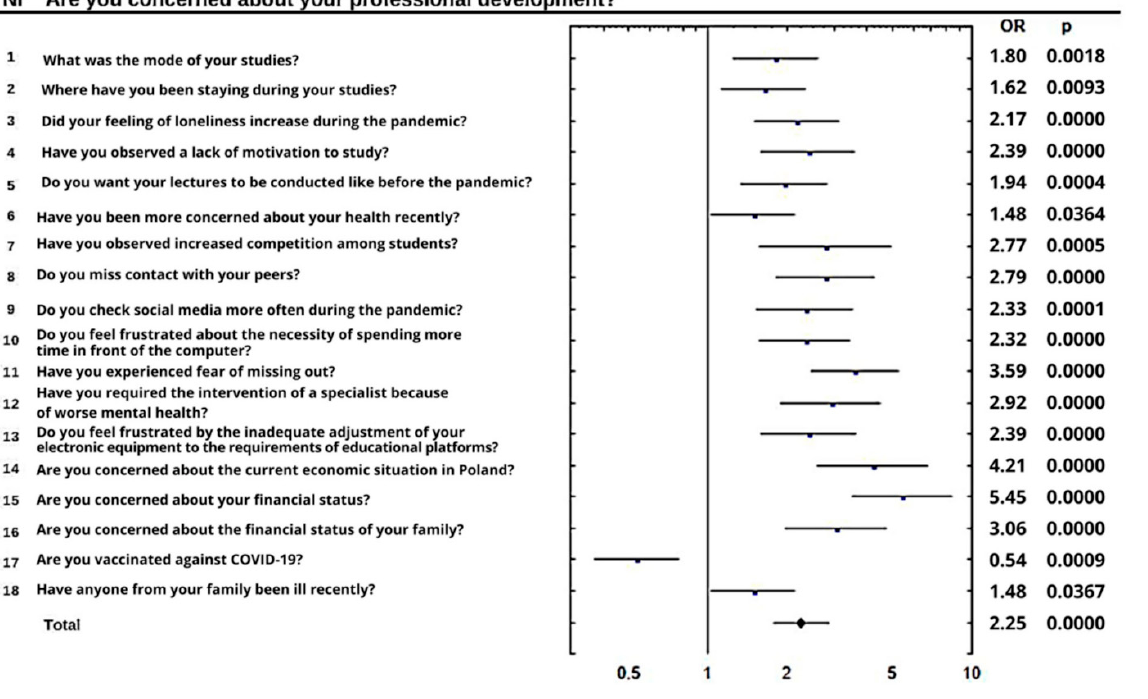
Figure 2. The impact of anxiety about personal development on other variables.